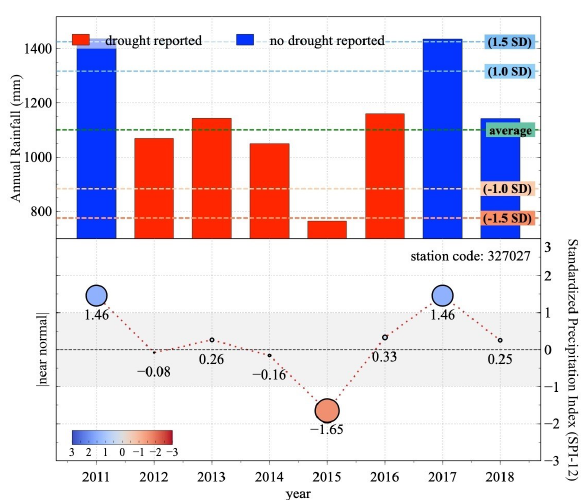
Fig. 11. Interpretation of SPI12 as drought indicator with the amount of annual rainfall and drought information at station Hot (327027).